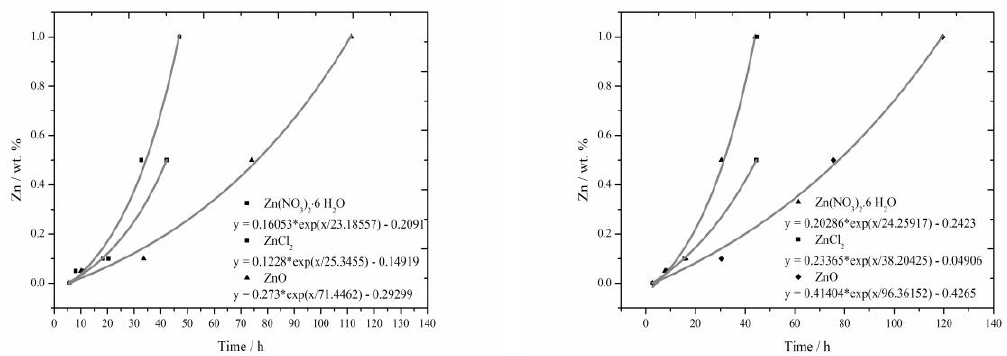
Figure 7. Graphical comparison of the lengths of the induction periods for isoperibolic (left) and isothermal (right) calorimetry.